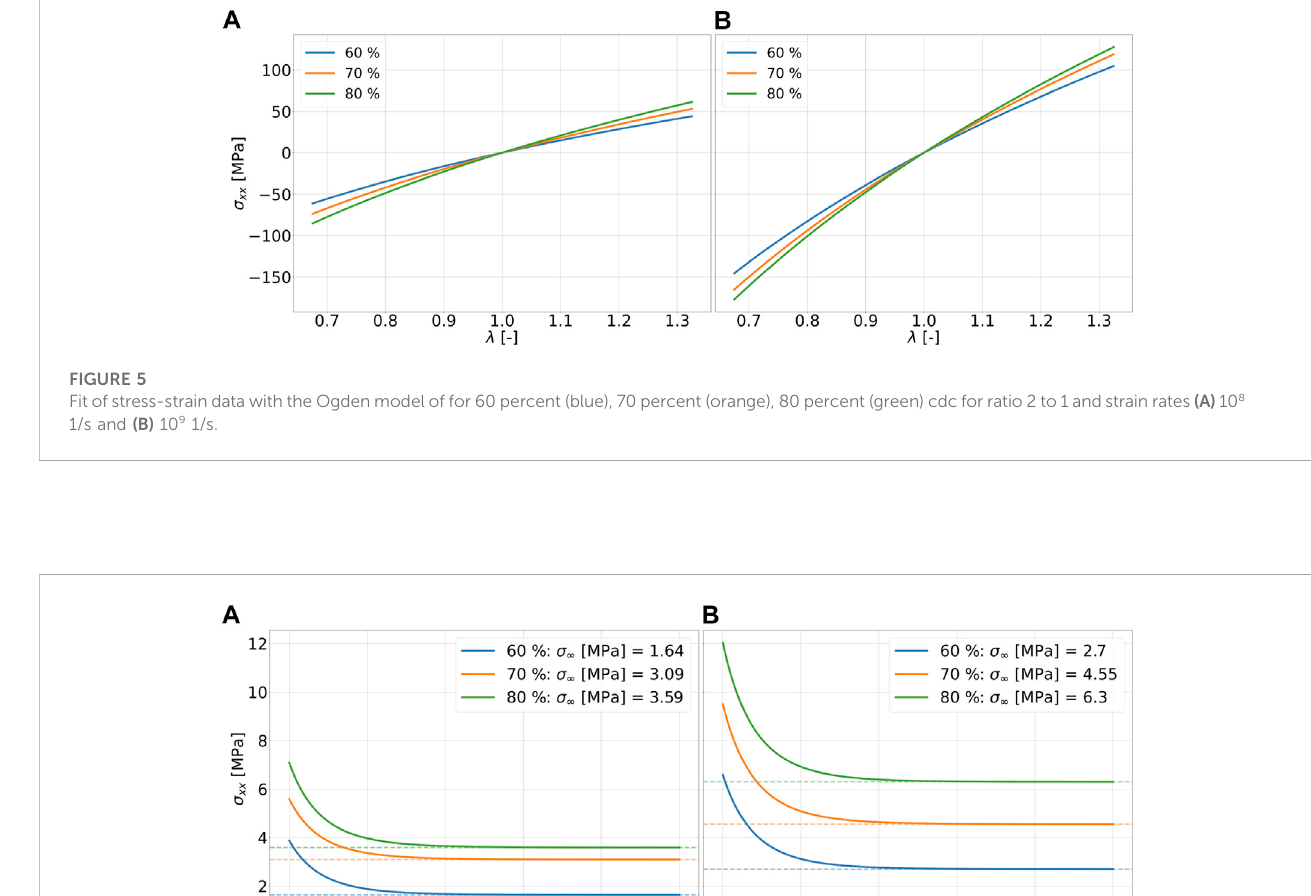
Frontiers in Built